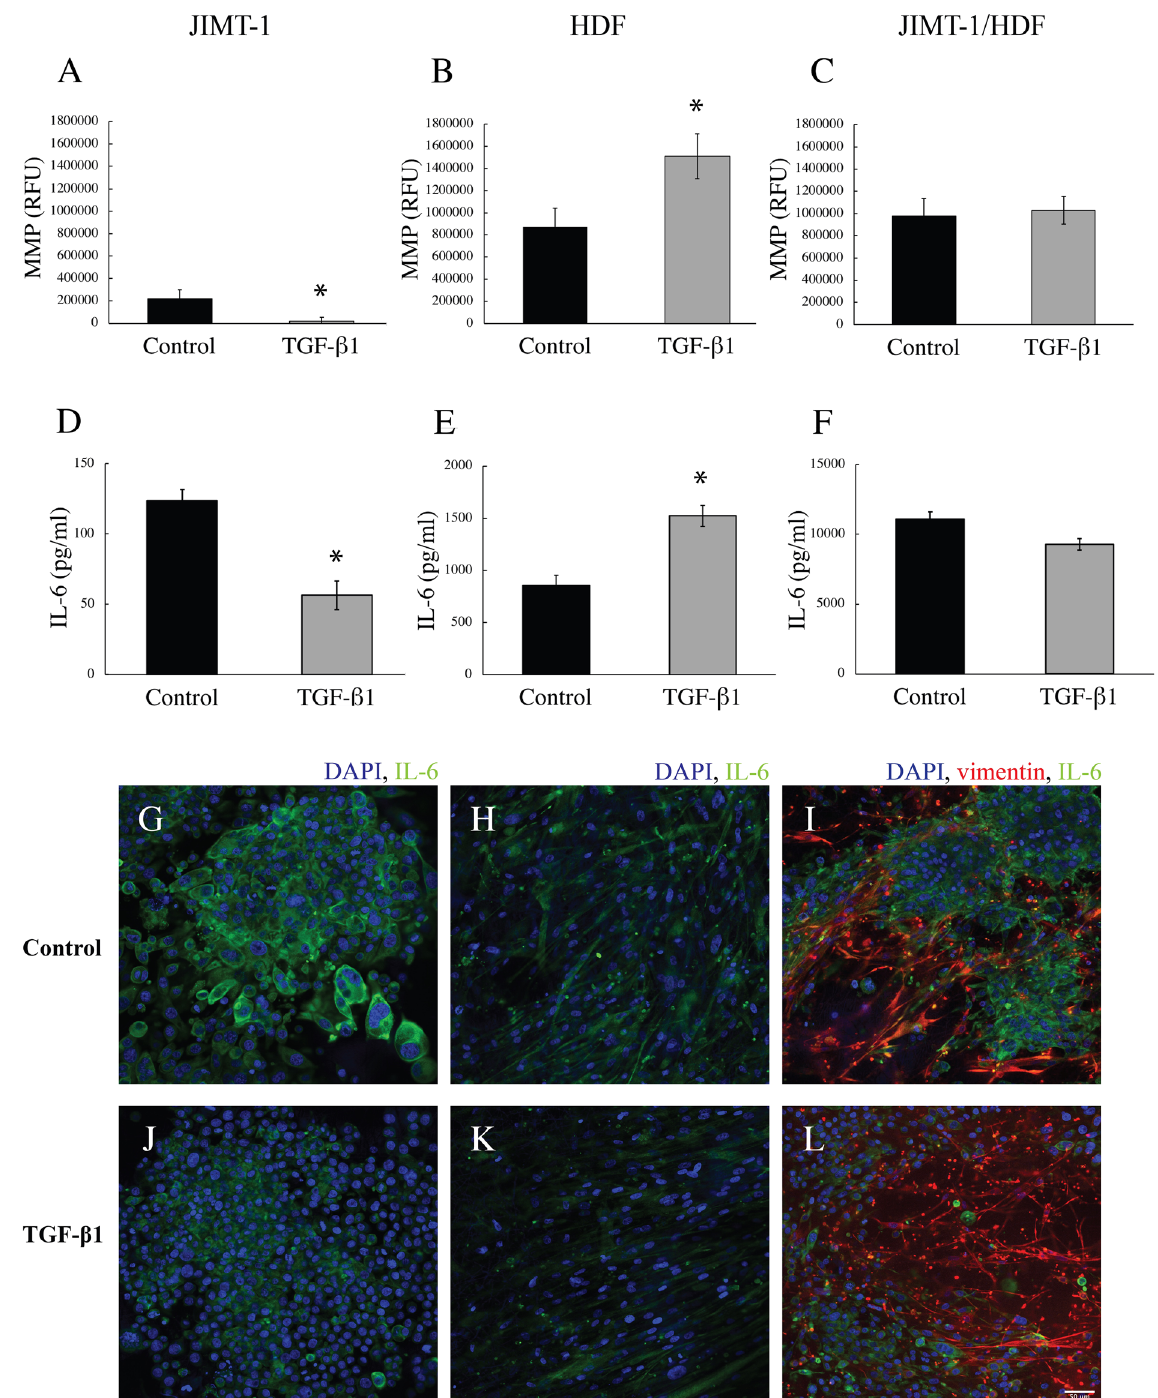
Figure 11. MMP activity and IL-6 level in the medium of JIMT-1 and HDF 3D mono-cultures and of JIMT1/ HDF 3D co-cultures. The cultures were incubated in the absence (control) or presence of 5 ng/ml TGF-β1. After 14 days of incubation, the medium was collected for analysis of MMP activity ( A – C ) and the concentration of IL-6 ( D – E ). ( A – C ) The MMP activity was determined in 50 μl of medium by an assay based on the formation of a fluorescent product produced by MMP enzyme activity. ( D – F ) The level of IL-6 in the medium was determined by an ELISA assay. ( G – L ) Following the collection of the culture media, the cells were fixed with 3.7% formaldehyde and stained to visualize IL-6 (green), vimentin (red), and cell nuclei (blue). The images show a single confocal microscopy plane taken in the centre of the cultures. Each column represents mean ± SEM (n = 5). Students t -test, * P < 0.05. Scale bar is 50